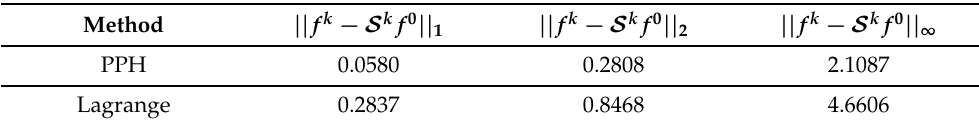
Table 6. Subdivision errors || g k − S k g 0 || p , p = 1,2, ∞ , committed by approximating the original data g k with S k g 0 for k = 5 subdivision levels starting from the initial function point values g 0 at the given grid X 2 with 20